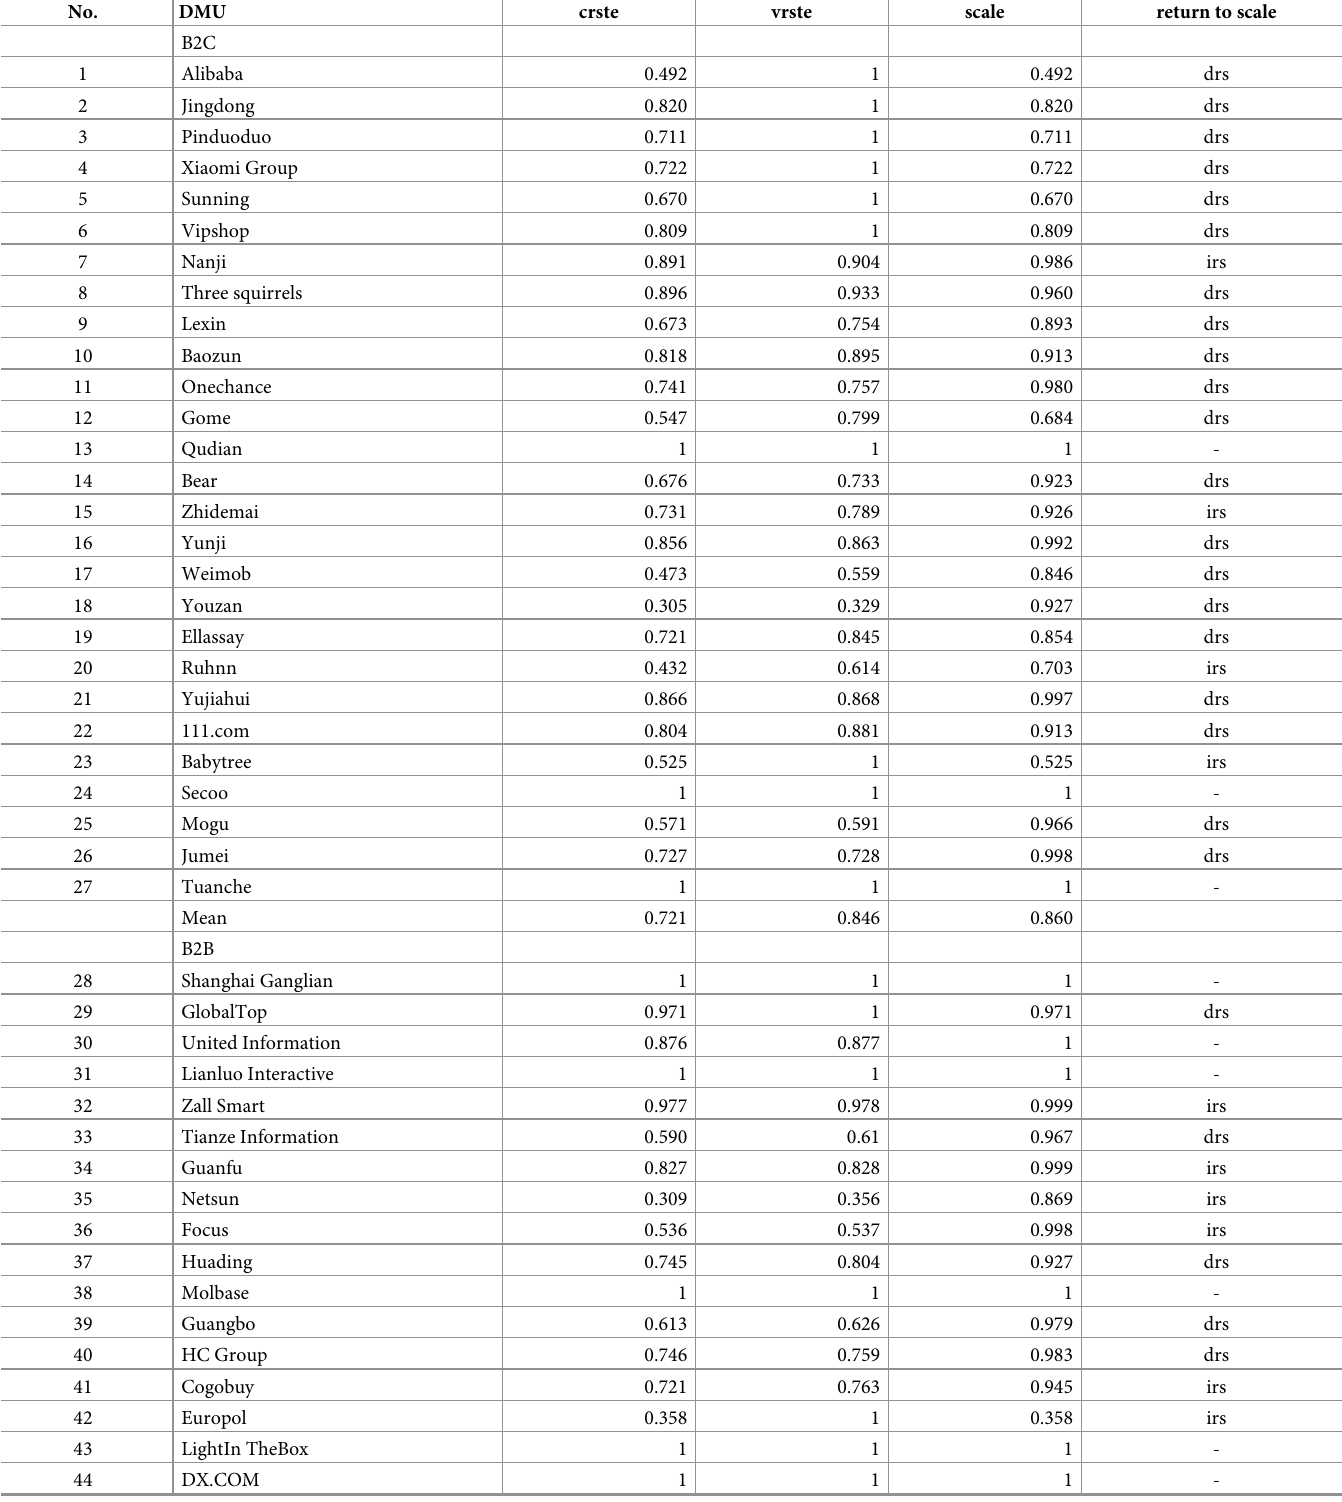
Table 2. Technical efficiency, pure technical efficiency, and scale efficiency of 65 e-commerce firms under the BCC in 2019.